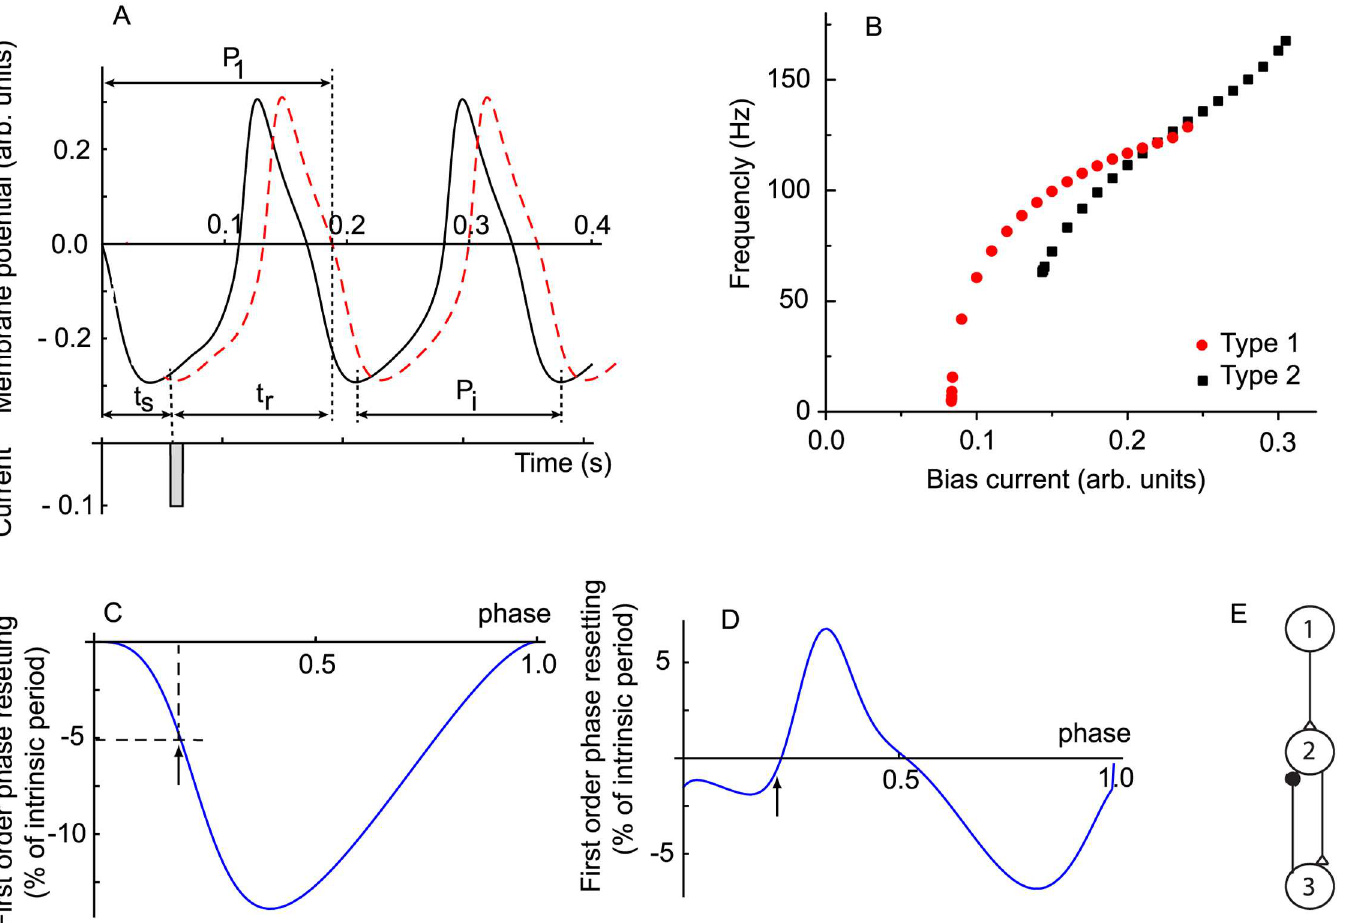
Fig 1. Typical PRCs for different classesof excitable cells. ( A ) The free runningneuraloscillator(continuousline) with an intrinsic period P i is perturbedat stimulus time t s by a brief current pulse (see shadedrectangle).As a result, the membranepotentialis perturbed(dashedline) and the periodof oscillationis transiently modified to P 1 , which inducesa phase shift of all subsequent spikes. The time it takes a neuronto recover from a stimulus until it reaches the arbitrary zero phasereference again is calledrecovery time t r . Higher order PRCs measurethe relativechange in the firing periodof the second and subsequent cycles (not shown). ( B ) Class I excitablecells can fire with arbitrarilylow frequency by adjustinga bias current (solid circles), whereasclass II excitablecells can only start firing at a minimum frequency (solid squares). The experimentally observedclass I/class II distinctionbetweenneuraloscillators translates in an (almost) one-to-onecorrespondence in type 1 (unimodal) PRCs ( C ) and, respectively, type 2 (bimodal) PRCs ( D ). The vertical arrow indicates a stimulus delivered at phase φ (cid:25) 0.2 that producesa 5% shorteningof the intrinsic firing periodin a type 1 ( C ) and 1% resetting in a type 2 ( D ) neural oscillator. The neuralnetwork for which we used the PRC to predict the phase-locked modes has three neurons: #1 is the pacemaker(master) of the network as it receives no feedbackand drive the half-center formed with neurons#2 and #3; neuron#2 (slave) receives two inputs: one forward excitatory (open triangle)from the master neuron#1 and the other inhibitory(solid circle) from the interneuron #3; the interneuron #3 only receives one excitatory input (open triangle)from neuron#2 (slave) ( E